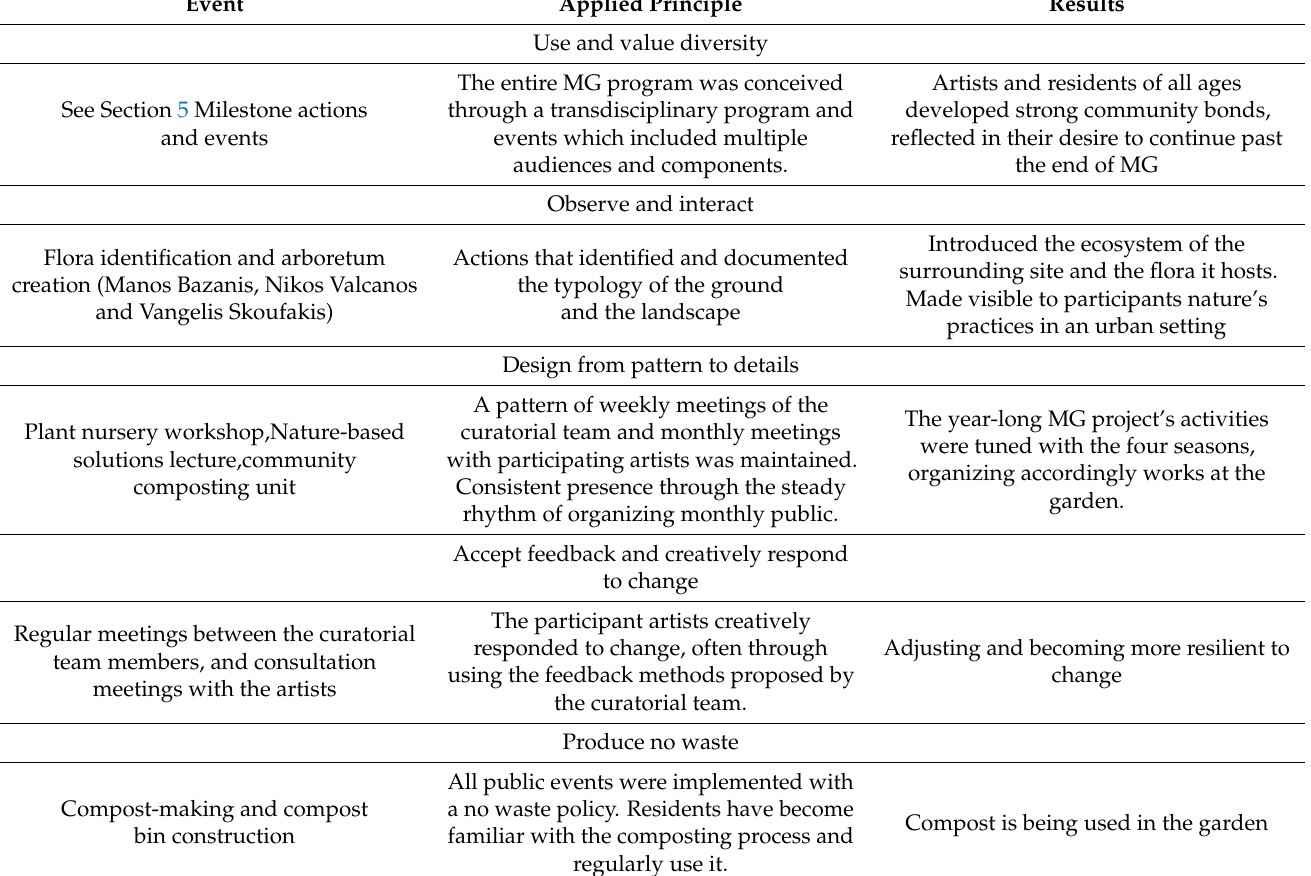
Table 1. Permaculture principles applied in various events and observed